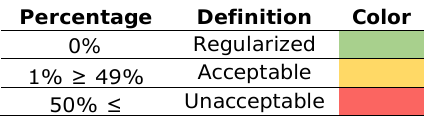
Table 1. Legend of colors for defining OSH